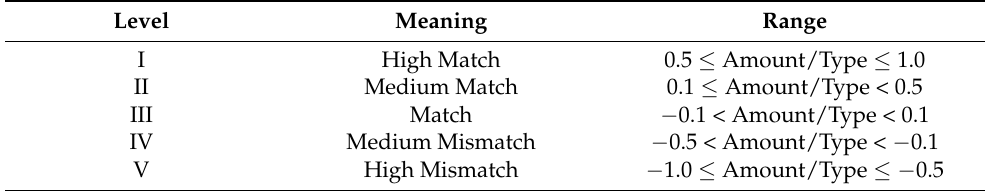
Table 1. Five level of amount index and type